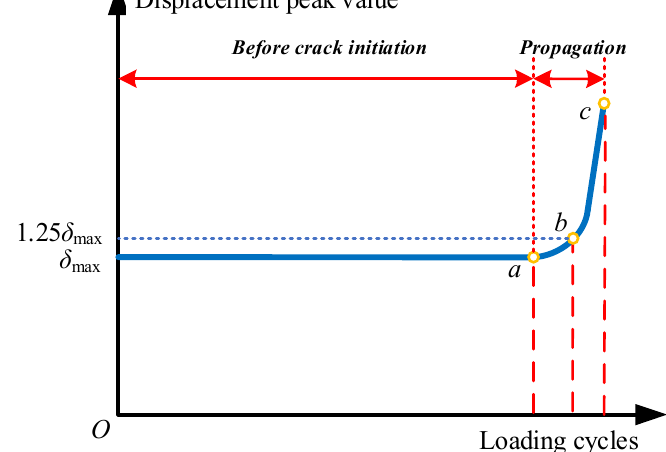
Figure 8. Illustration for fatigue life definition.